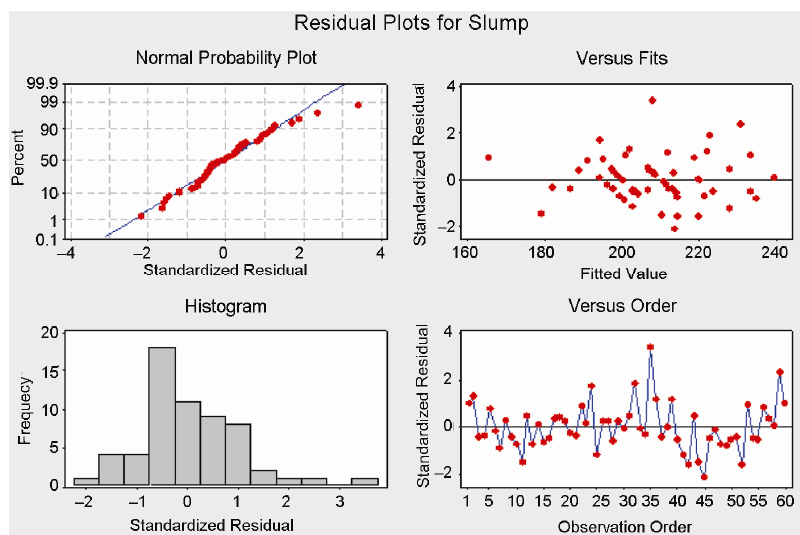
Fig. 2. Residual plots of the slump model